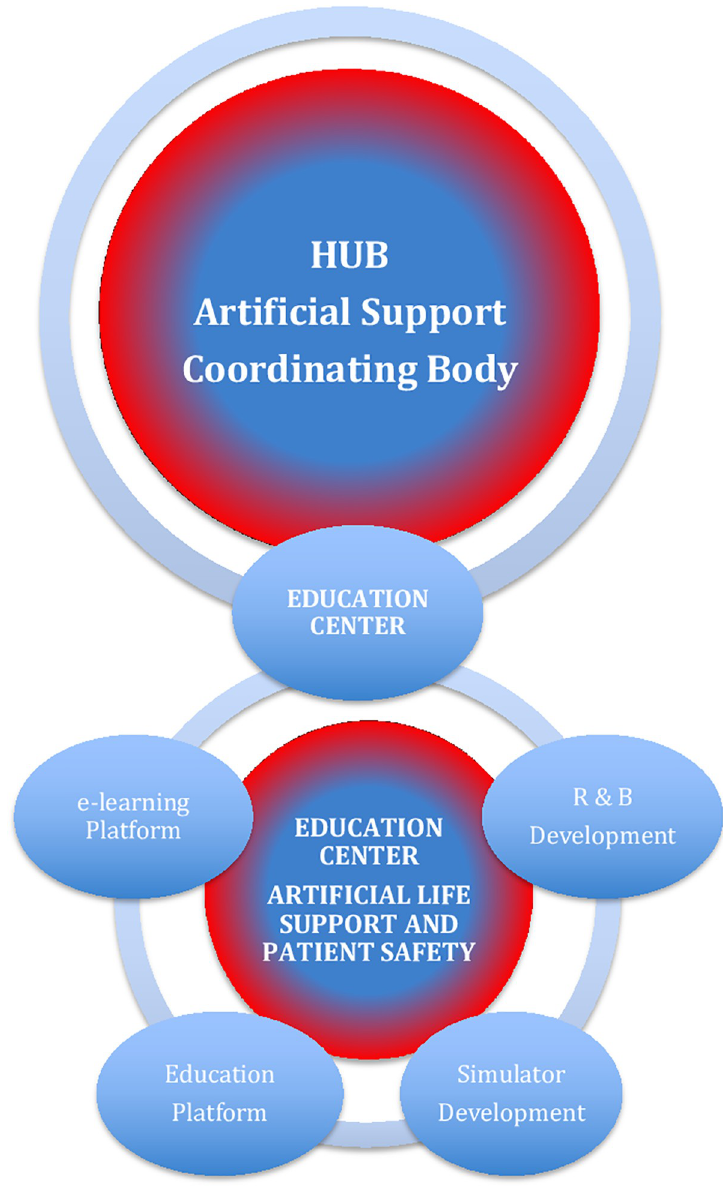
Fig 6. R&D development: „know-how and knowledge transfer” in education center of artificial support in „ECMO for greater Poland” innovation ecosystem.